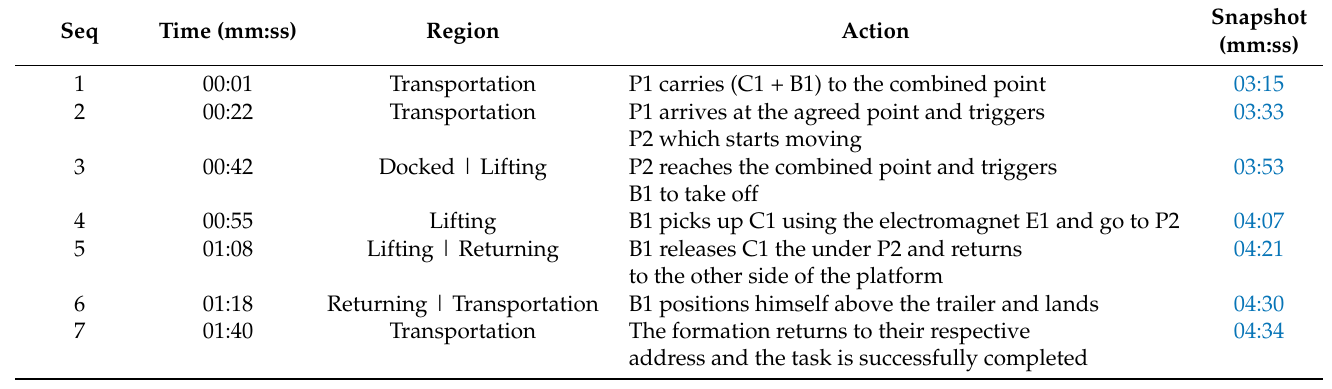
Table 3. Sequence of events of the experiment 2.